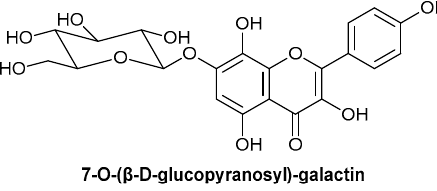
Figure 4. Chemical structure of flavonoid 7-O-( β -D-glucopyranosyl)-galactin, the active component of A. pichinchensis (Kunth).